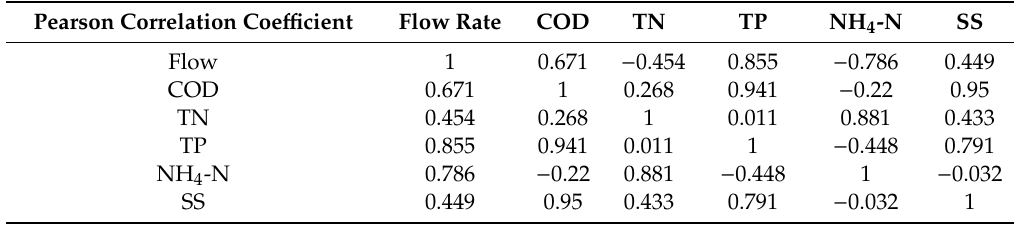
Table 4. Correlation analysis of pollution indexes.